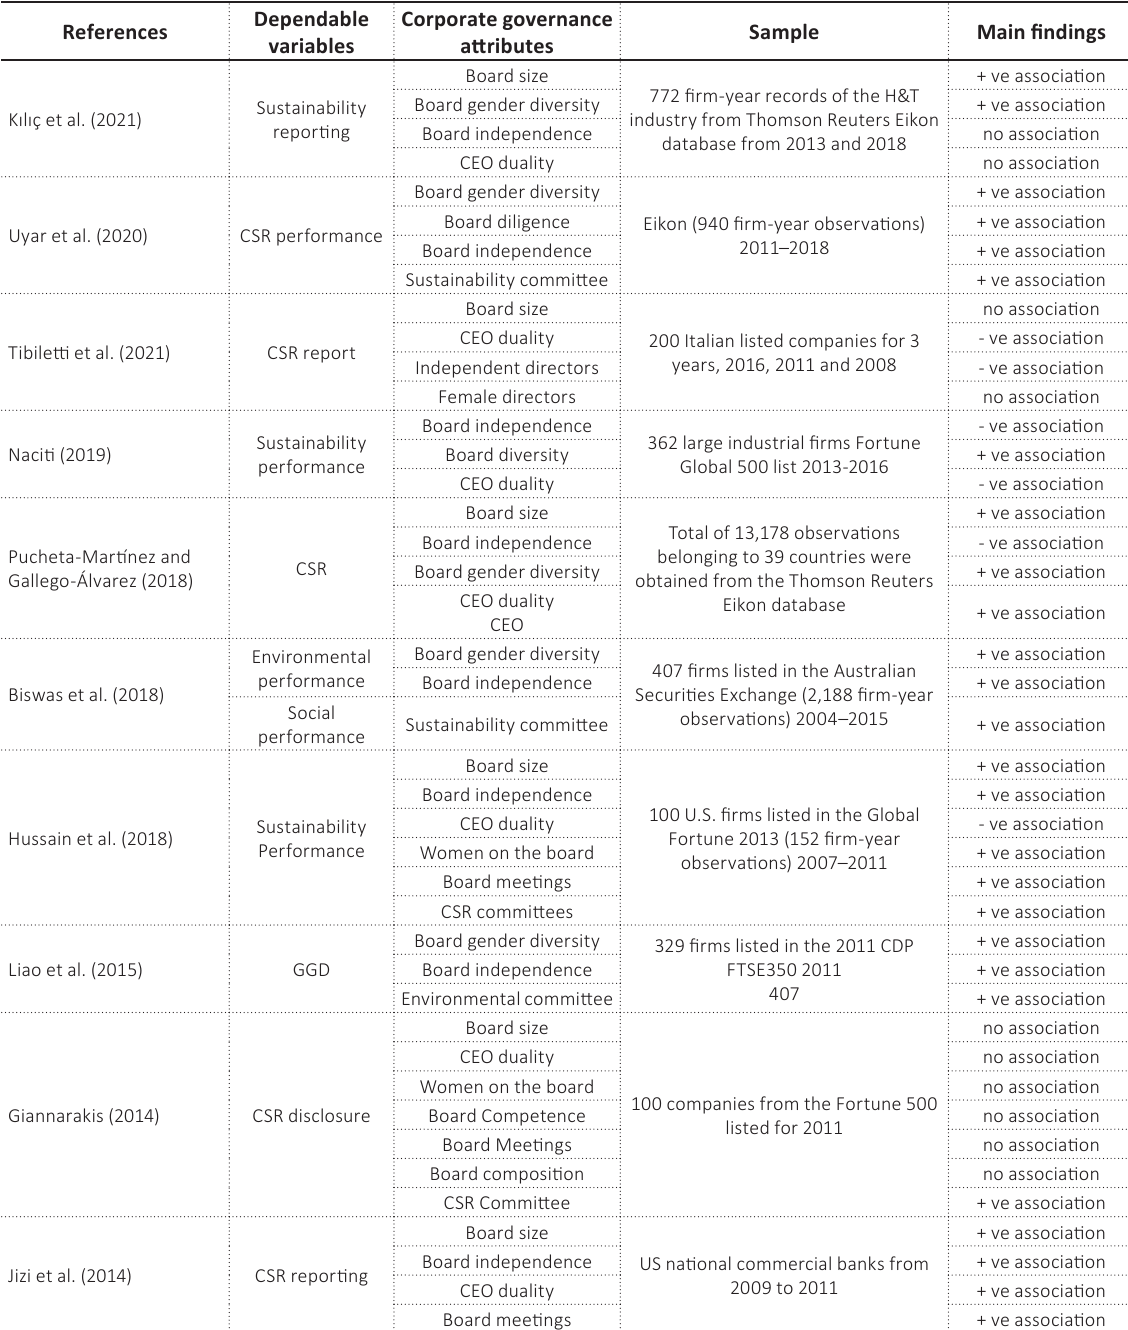
Table 1. Prior studies on the effect of sustainability reporting conduct and corporate governance